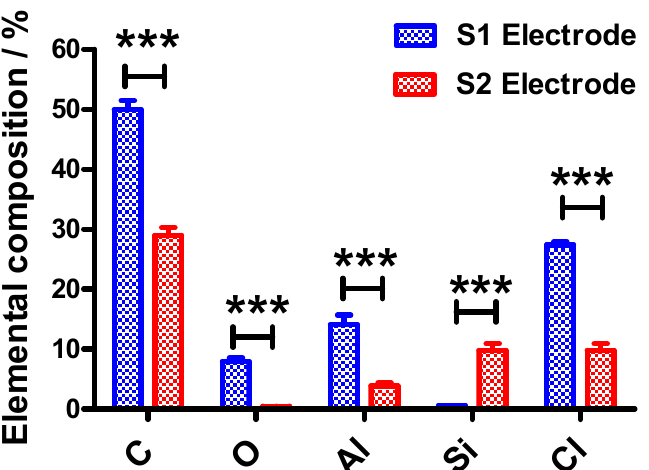
Figure 2. The elemental compositions of the S1 and S2 electrodes showing the percentage of carbon (C), oxygen (O), aluminum (Al), silicon (Si) and chlorine (Cl) which were determined from EDX measurements. Statistical analyses were performed using two-way ANOVA, followed by a Bonferroni test. Data shown as mean ± S.D., n = 3 and *** denotes p <